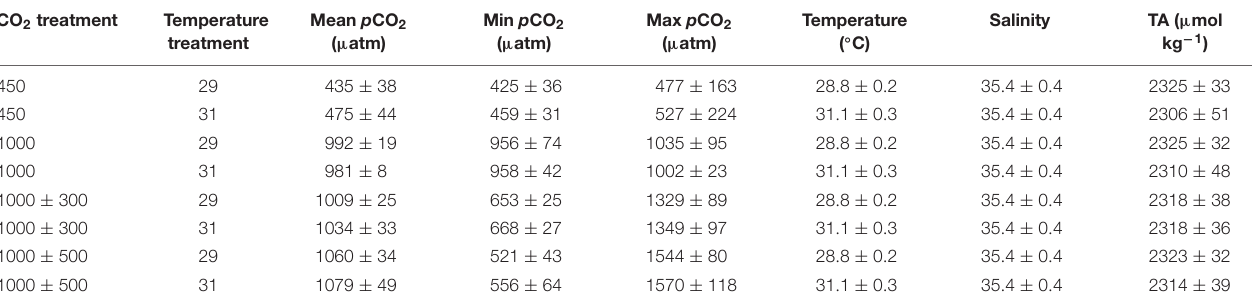
TABLE 1 | Experimental seawater